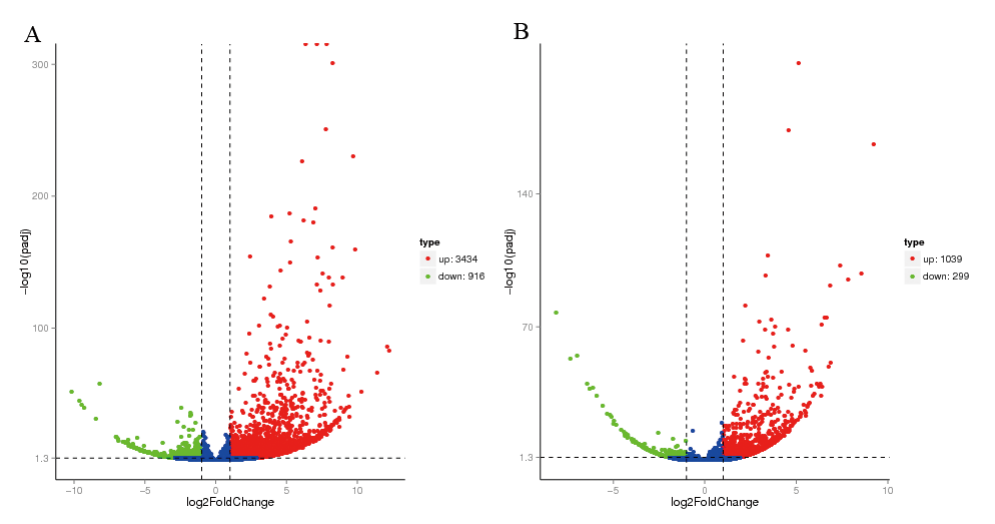
Figure 2. A volcano plot showing DGE in the brainstem of gerbils infected by EV71 ( A ) and CVA16 ( B ) compared to that of the control gerbils. The blue dots mean not significant changed genes. The horizontal dotted line represents the threshold of statistical significance, and the vertical dotted line represents the threshold of fold